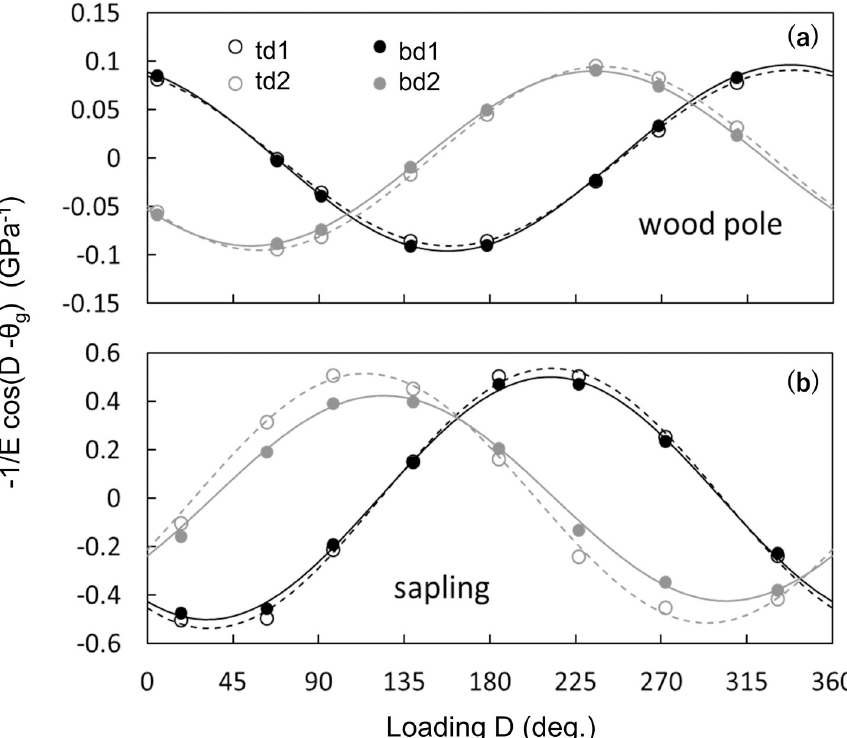
Fig 7. Curves of 1/E � cos(D- θ g ). The results for the (a) wood pole and (b) sapling tests. Here, we used the function with negative sign, -1/E � cos(D- θ g), because this form is adapted to outputs of a strain gauge which gives a positive value for tension and a negative value for compression. For each panel, circles show the measurement values from each rotation and lines show the fitted curves. D (degrees) is the radial direction of loading F, θ g (degrees) is the direction of each strain gauge on the specimen, and E (GPa) is the modulus of elasticity. Black open circles and black dashed lines, strain gauge td1; black solid circles and black solid lines, strain gauge bd1; grey open circles and grey dashed lines, strain gauge td2; and grey solid circles and grey solid lines, strain gauge bd2. For the E and θ g values of each strain gauge, see Table 2.